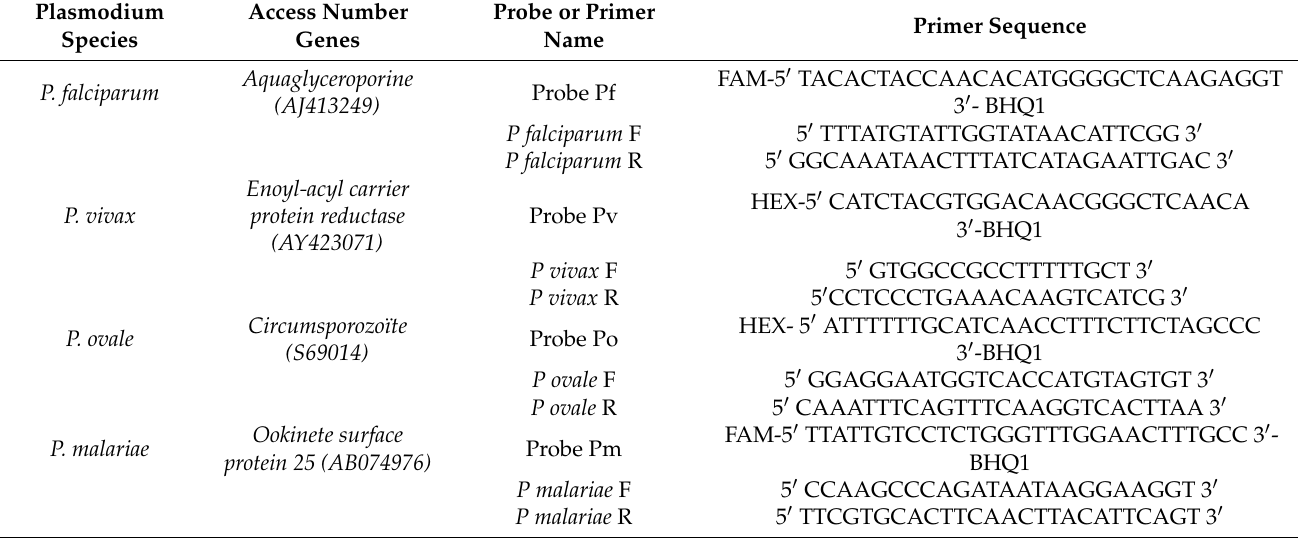
Table 2. Sequences of primers and probes for reference